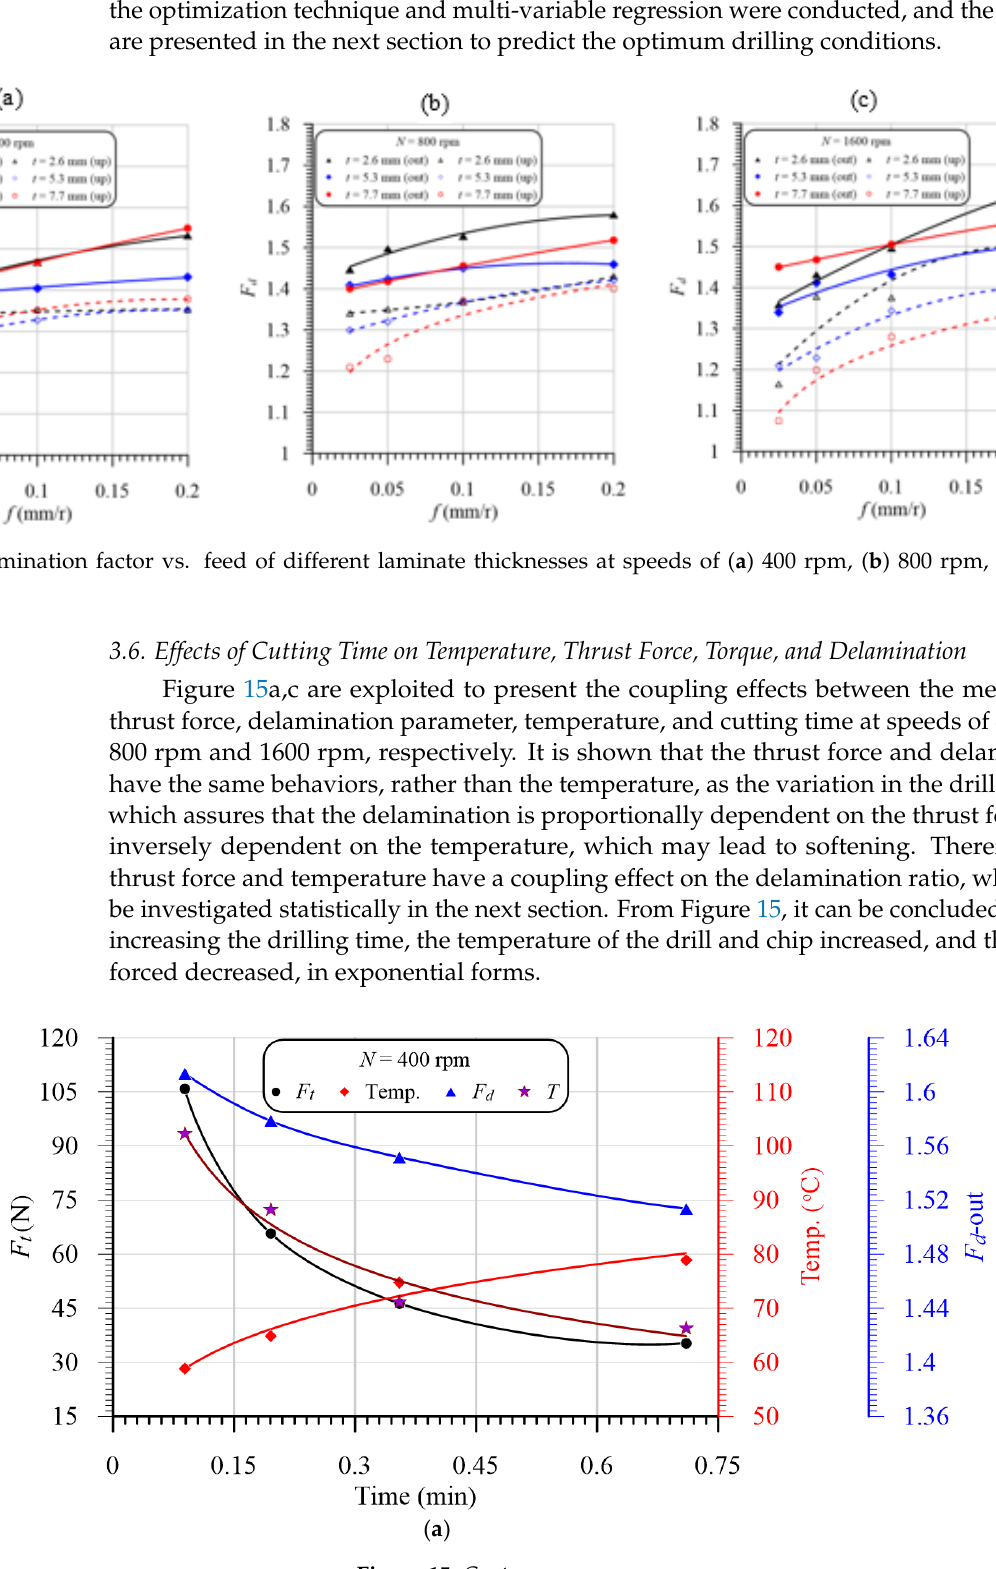
( b ) ( c ) Figure 15. Variation in thrust force, delamination, and temperature vs. the cutting time at different speeds. ( a ) N = 400 rpm; ( b ) N = 800 rpm; ( c ) N = 1600 rpm.